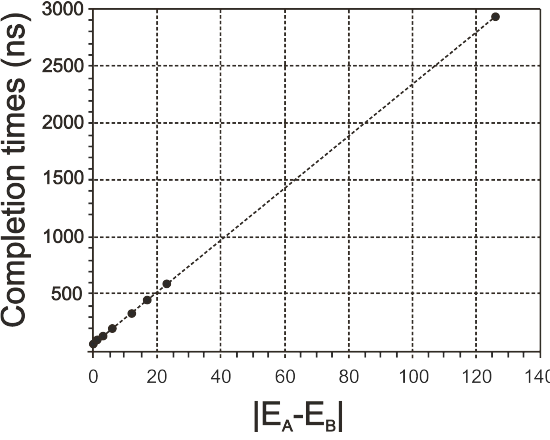
Figure 7. Addition completion times (ordinary cases) in ns as a function of | E A − E B |